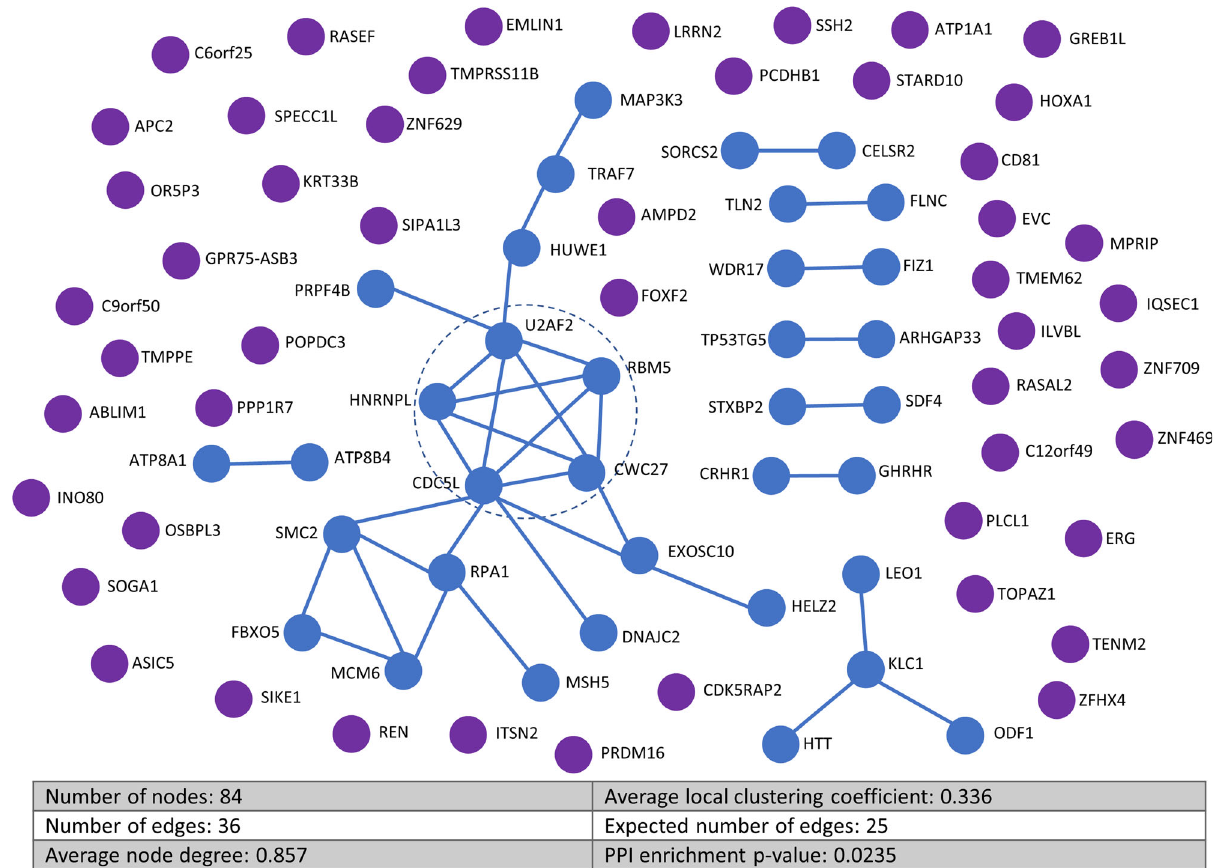
Fig. 2 Protein – protein interactions predicted for proteins affected by pathogenic de novo mutations. Signi fi cantly larger number of interactions were observed in proteins affected by de novo mutations than expected for a similar sized dataset of randomly selected proteins (PPI enrichment p value = 2.35 × 10 − 2 ). The central module of the main interaction network (blue dashed circle) contains 5 proteins involved in mRNA splicing (Supplementary Fig.